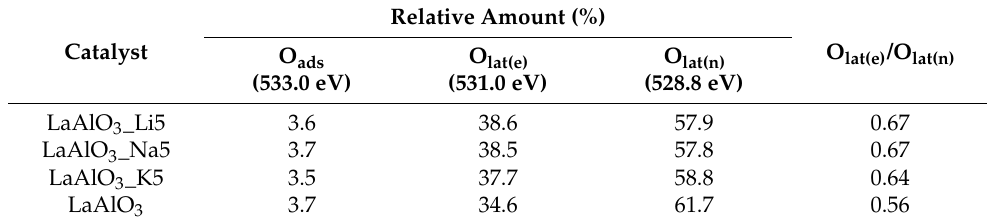
Figure 5. O 1s X-ray photoelectron spectroscopy (XPS) spectra of LaAlO 3 _X5 (X = Li, Na, K) and LaAlO 3 catalysts. Table 3. Curve-fitted and quantified O 1s XPS peaks for LaAlO 3 _X5 (X = Li, Na, K) and LaAlO 3 catalysts.